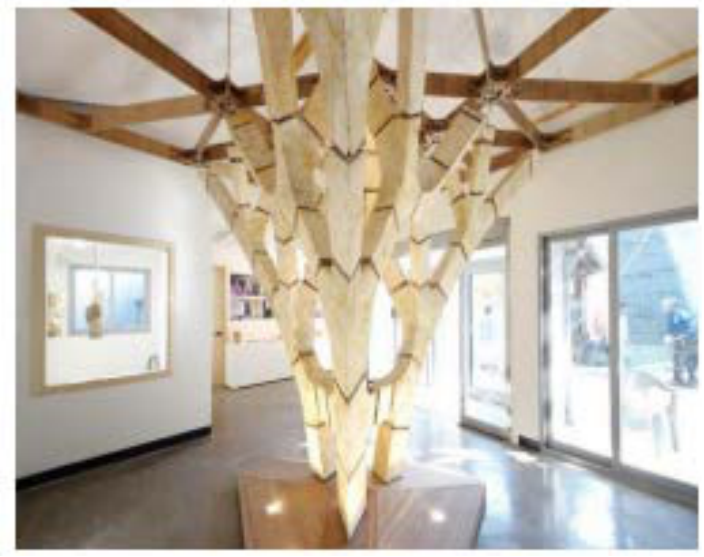
Figure 11 MycoTree-2017 (Heisel et al., 2017).